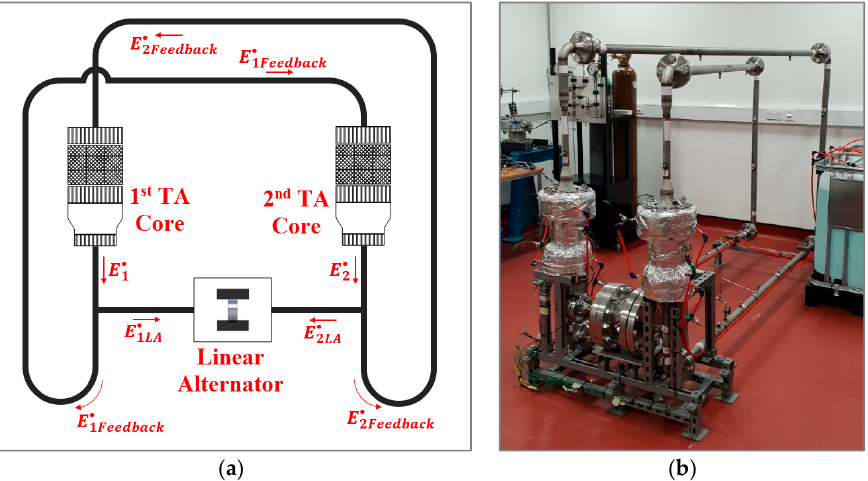
Figure 1. ( a ) Conceptual drawing of the engine; ( b ) Photo of the thermoacoustic engine reported here.